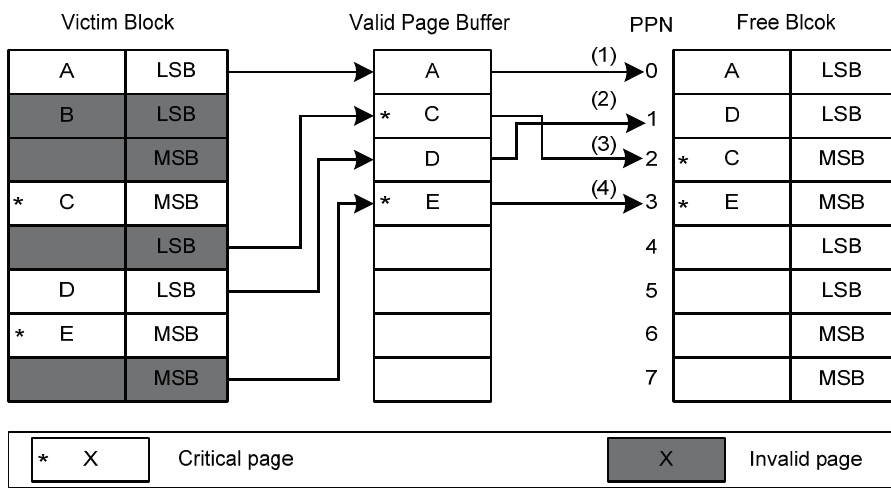
Figure 8. An example of the valid page copy strategy of the asymmetric garbage